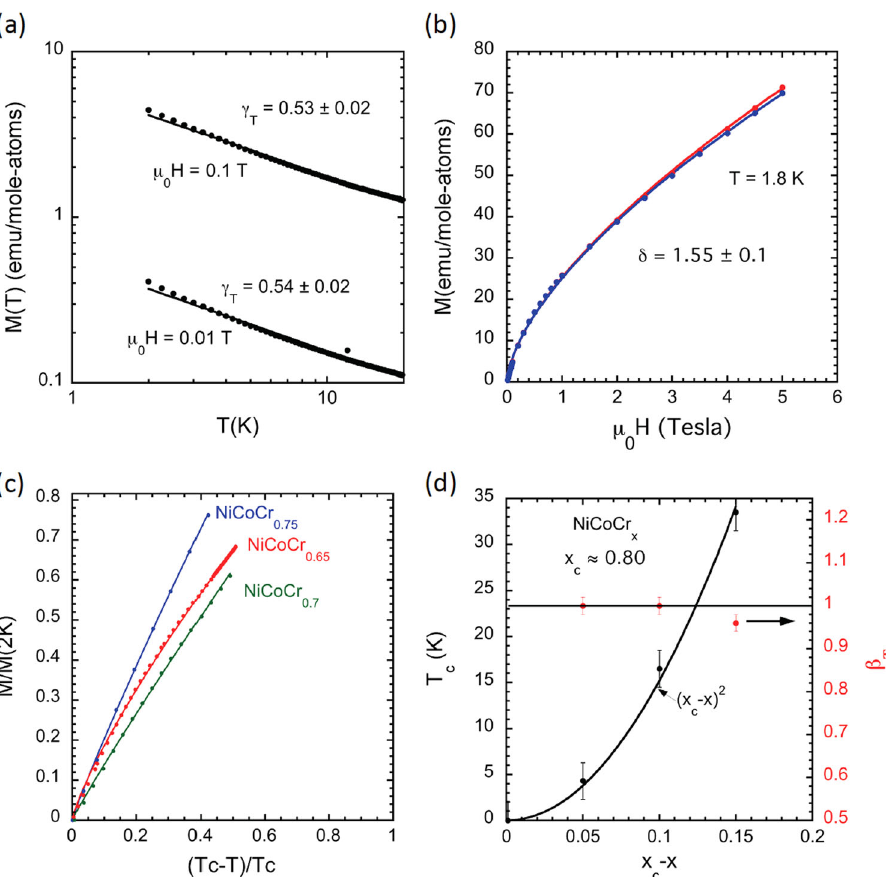
Fig. 3 Critical exponents from magnetization data a Magnetization vs temperature for a NiCoCr 0.8 crystal in applied magnetic fi elds of μ 0 H = 0.01 and 0.1 Tesla. For these low applied fi elds the susceptibility, χ , is given by M/H. The solid lines are least square fi ts of the data to a power law T − γ T , with the values for γ T as shown in the fi gure. The error bars for γ T correspond to the standard error of the mean (s.e.m.) from multiple samples. b magnetization vs applied magnetic fi eld at our lowest temperature for two NiCoCr 0.8 crystals, and the value of δ determined from these isotherms The relatively large error bars (s.e.m.) for δ re fl ect the uncertainty on whether to include the low fi eld magnetization data where domain effects can be important 22, 24 c Increase of the magnetization below T c with an applied fi eld of 0.01 T for three ferromagnetic polycrystalline samples. The lines are power law fi ts to all the data shown. Values of β T are obtained by fi ts over smaller T c -T intervals near T c . The small error bars (s.e.m.) for β T in panel d re fl ect the insensitivity of the analysis to the exact value chosen for T c . d Curie temperature vs. ( x c − x ), where x is the Cr concentration, and x c is the concentration where T c ≈ 0. The error bars (s.e.m.) on T c re fl ect the results from different methods used to determine T c . The solid line is a force fi t of the T c data to ( x c − x ) 2 , the functional dependence expected from BKV theory. The values of the critical exponent β T as estimated for the same ferromagnetic samples x = 0.75, 0.7, 0.65. (1 emu = 1 mA m 2 in SI